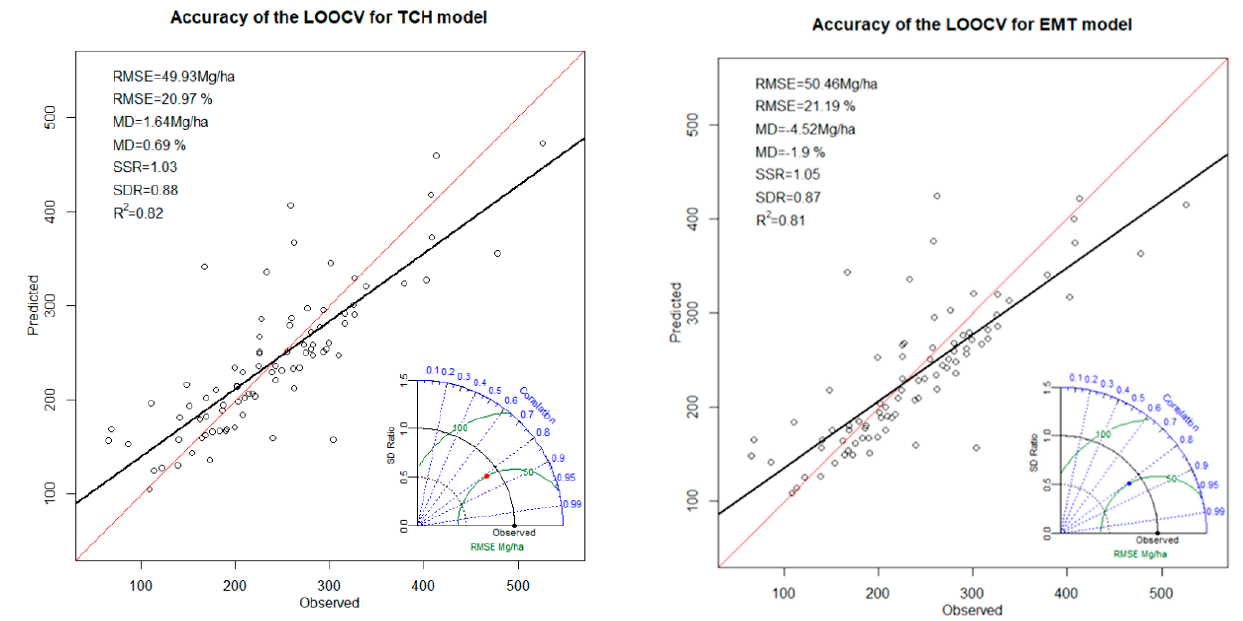
Figure 7. Graphs of Comparison of predicted vs observed AGB in Mg/ha for the LOOCV of the TCH and EMT models with inset statistical analysis results and a Taylor diagram representing how well the models’ predictions reflect the observed data in terms of the ratio of their standard deviations, the correlation of the data, and the RMSE.